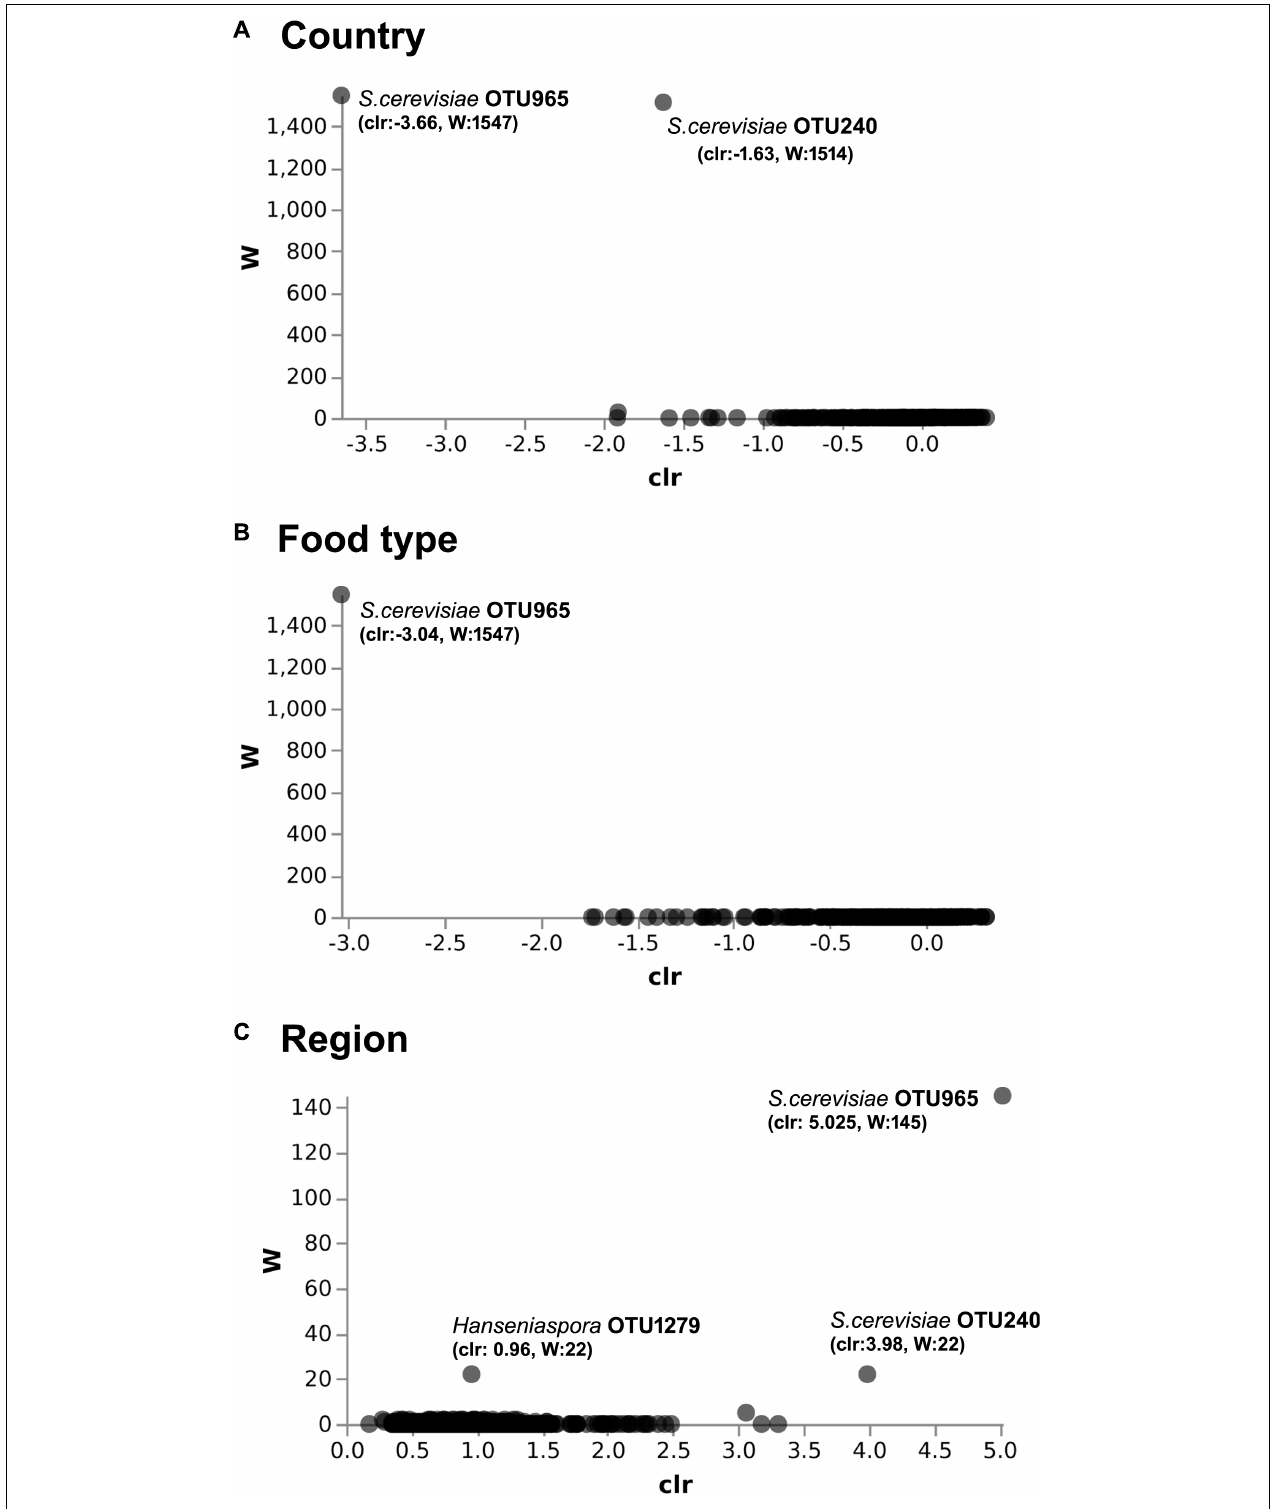
FIGURE 4 | ANCOM differential abundance testing shows the yeast taxa significantly differ across the (A) country (Benin and Niger) and (B) food type (fermented milk and cheese). (C) No significant difference observed between the regions of sample collection. QIIME2 version 2019.1 was used for ANCOM analysis. The percentile abundances of features by the group of significantly differing yeast taxa are shown in Table 2